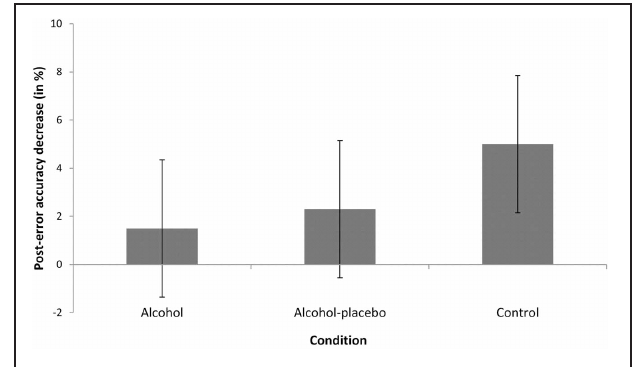
FIGURE 2 | Displays the congruency effect (incongruent–congruent) in ms for trials following correct and incorrect responses for the alcohol, alcohol-placebo, and control group. Error bars represent 95% within-subjects confidence intervals based on the mean square error term of the interaction between previous accuracy and condition (Loftus and Masson, 1994).